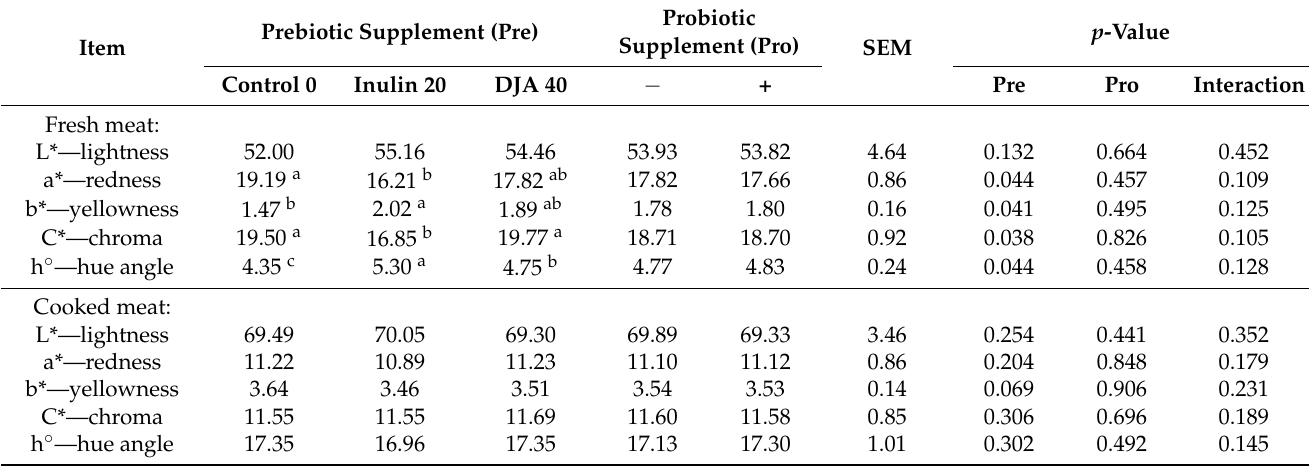
Table 5. Color parameters (CIE L*a*b*) of meat (m. longissimus lumborum).